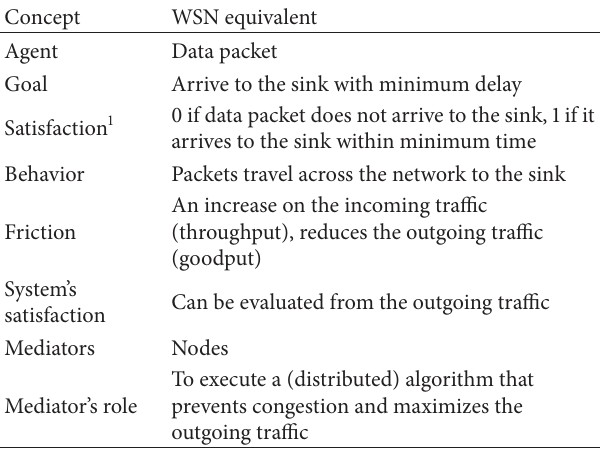
Table 1: Complex systems concepts and their equivalences for the proposed WSN